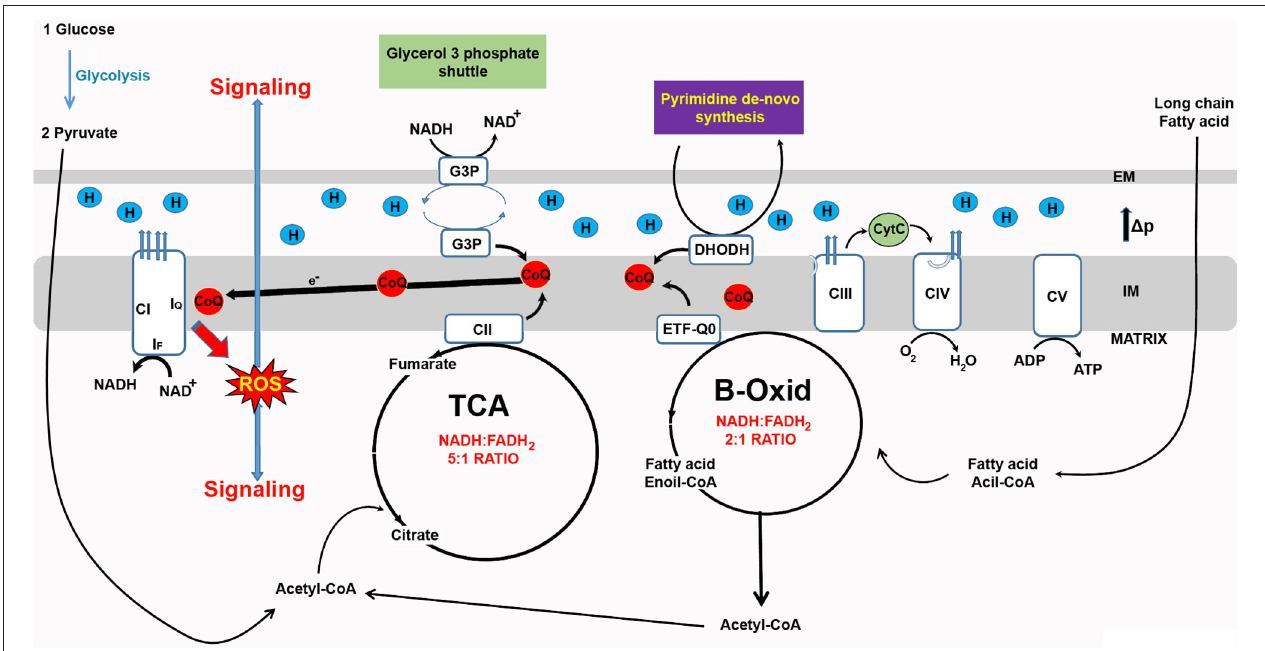
FIGURE 2 | Reverse electron transfer (RET) as a new ROS-based mitochondrial signaling pathway. The redox state of the CoQ pool determines electron leak and superoxide production and can be used by mitochondria as a signaling mechanism. Since RET is sensitive to changes in electron flow and membrane potential, it can be used to detect changes in energy supply and fine-tune cell metabolism. For example, an increase in the availability fatty acid alters the NADH:FADH2 ratio from 5:1 to 2:1 and in response levels of CI are reshuffled by ROS produced via RET (RET-ROS) (Guaras et al.,